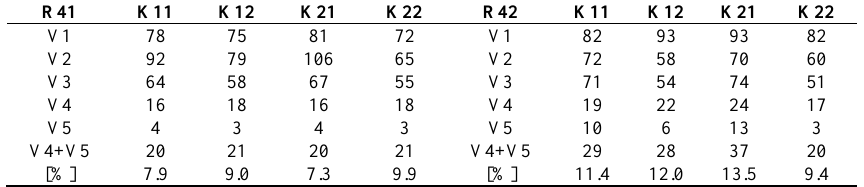
Table 4. The evaluation of sources of operational risk by